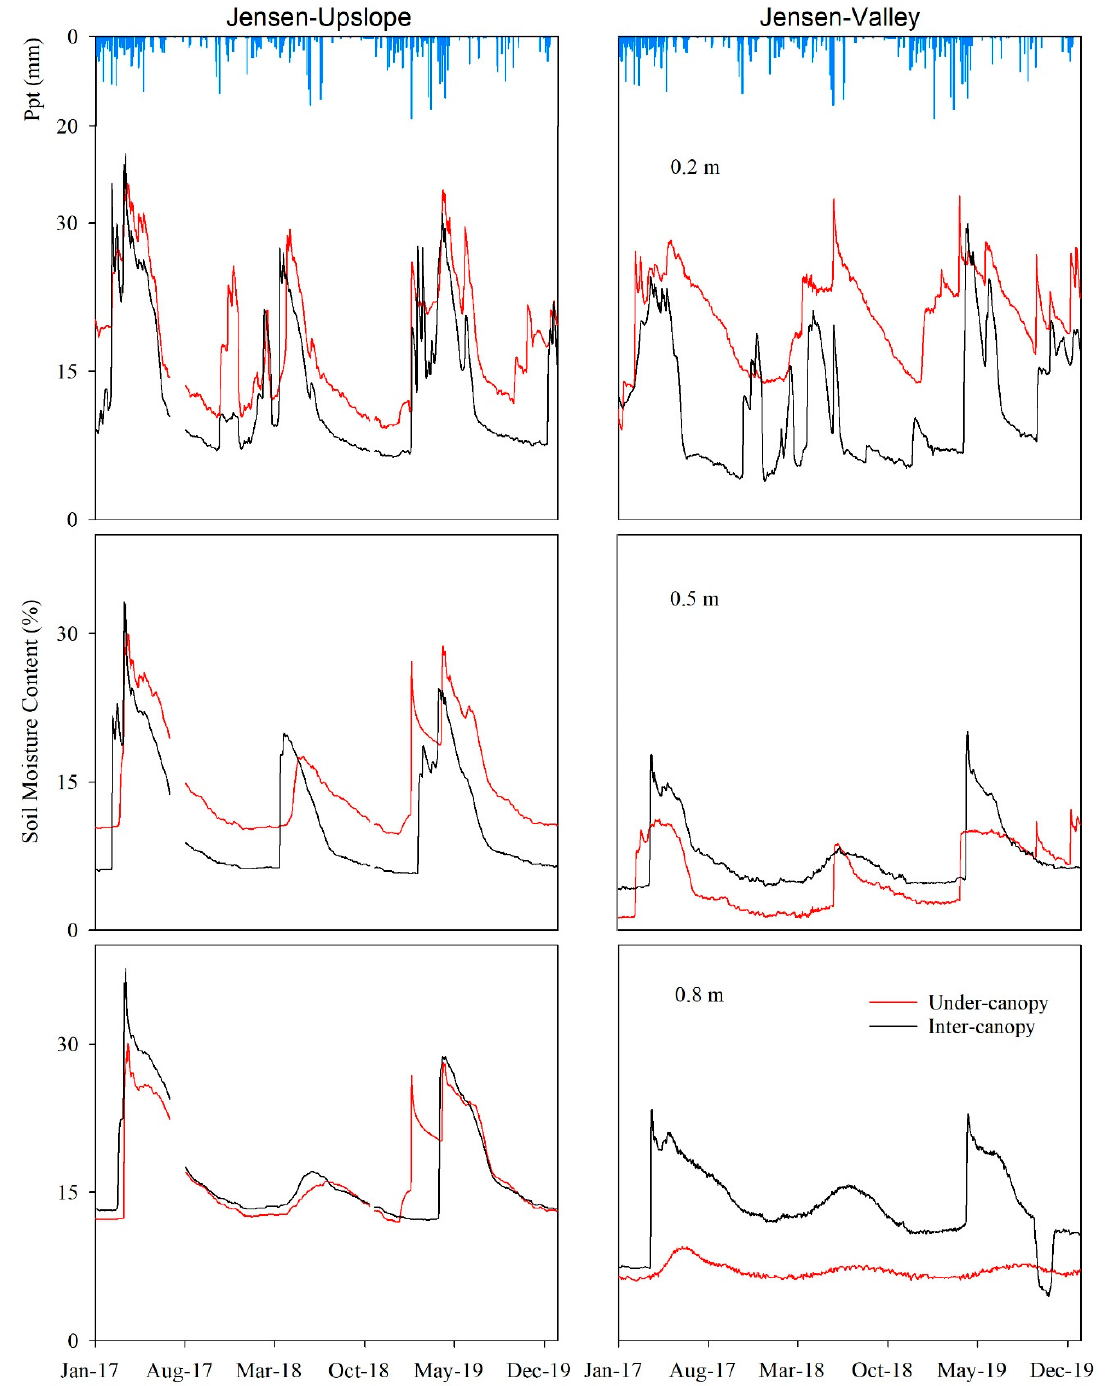
Figure 5. Daily averaged precipitation (Ppt) and soil moisture content ( θ ) at different soil depths (0.2, 0.5, and 0.8 m) in inter ‐ canopy and under ‐ canopy zones for Jensen ‐ Upslope and Jensen ‐ Valley monitoring locations in Jensen